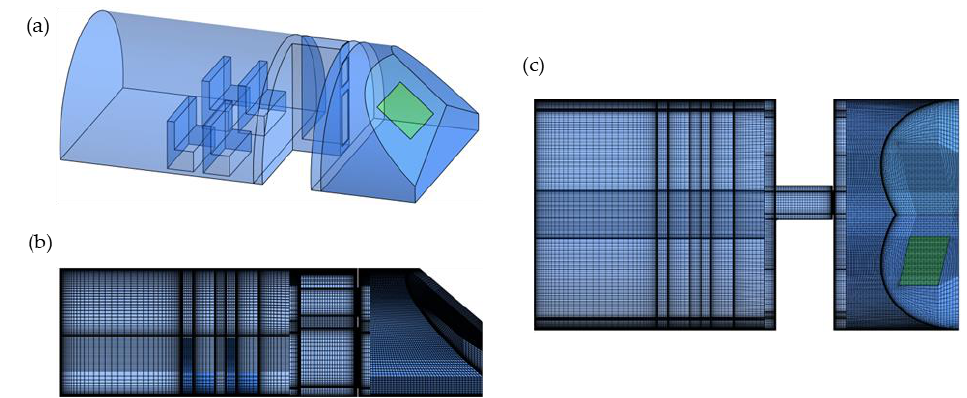
Figure 10. Geometry and mesh model of 3-D simulation: ( a ) simulation domain, ( b ) main view of the mesh, and ( c ) top view of mesh.